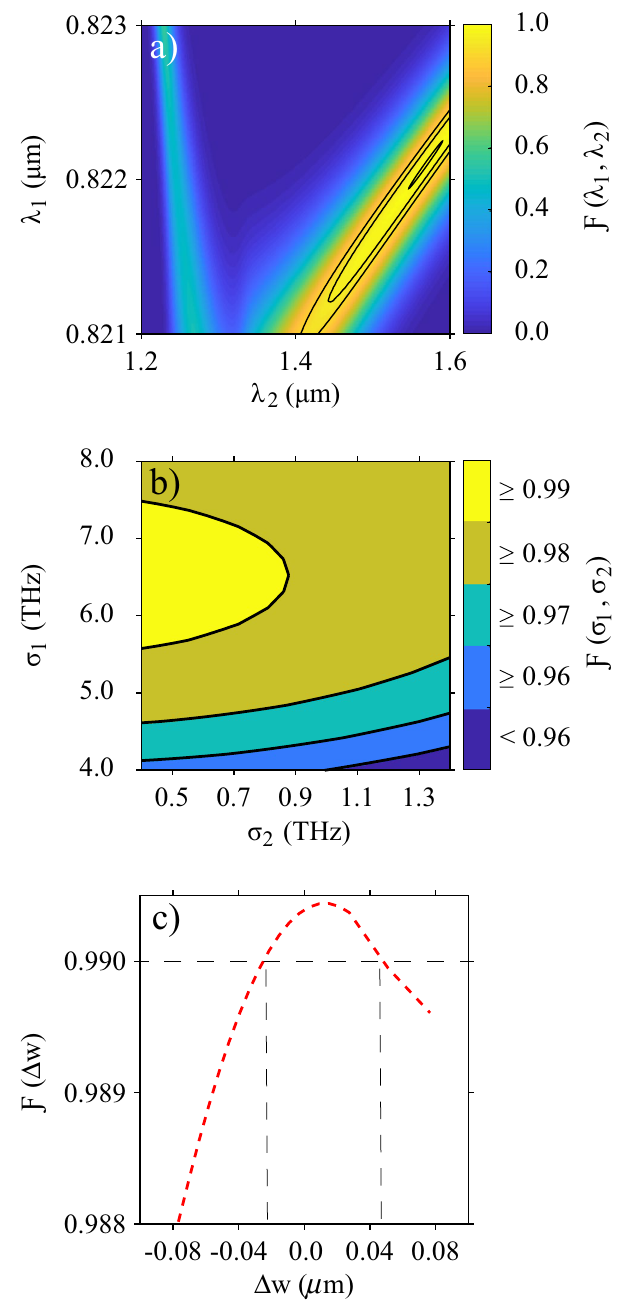
Figure 3. Color qubit preparation fidelity as a function of ( a ) the pump wavelengths, ( b ) the pump bandwidths, and ( c ) variations in the SFWM and DFG waveguide widths, while the remaining parameters of the SFWM and DFG sources are fixed to the values in Table